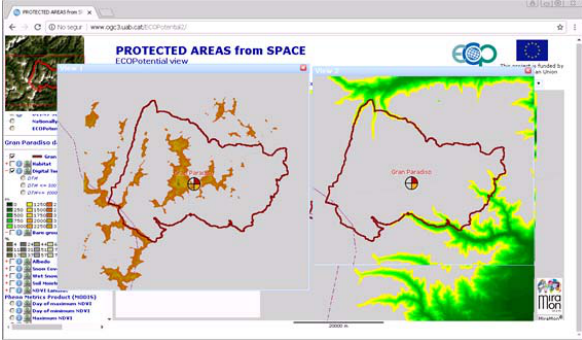
Figure 10. Selections from the Gran Paradiso Natural Park DEM. On the left, areas over 3000 m, and on the right, areas under 1500